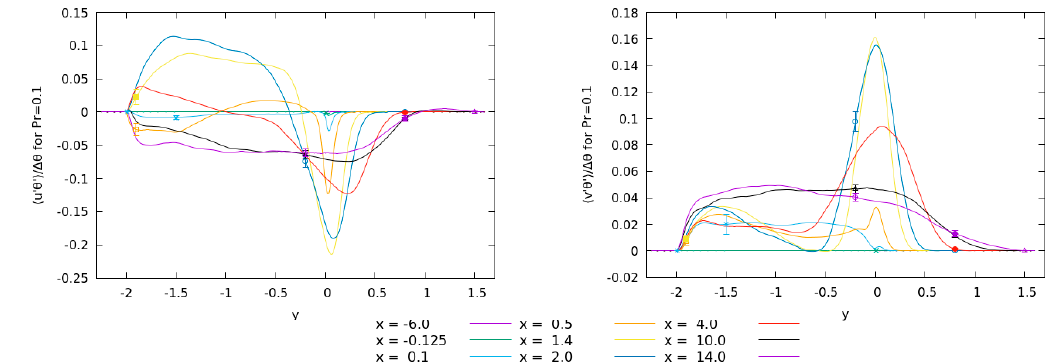
Figure 10. Profile of turbulent heat flux components for passive scalar with Pr = 0.1 toghether with values and uncertainties calculated in monitor points through the plane 𝑧 = 0 .